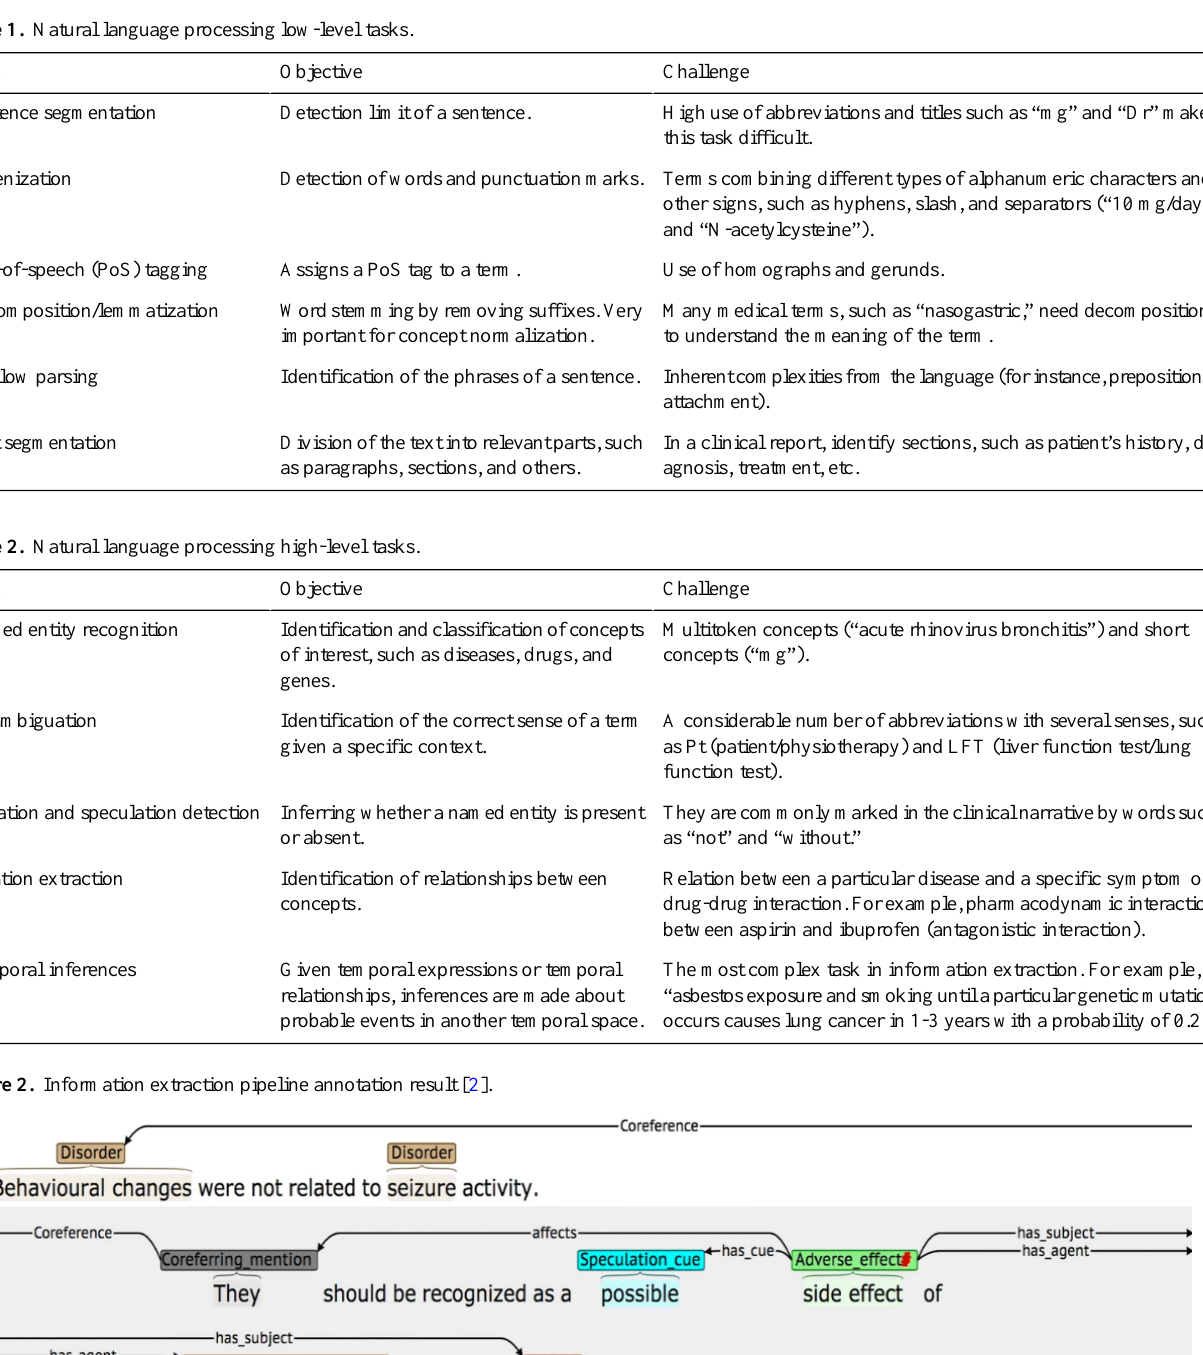
Table 1. Natural language processing low-level tasks.